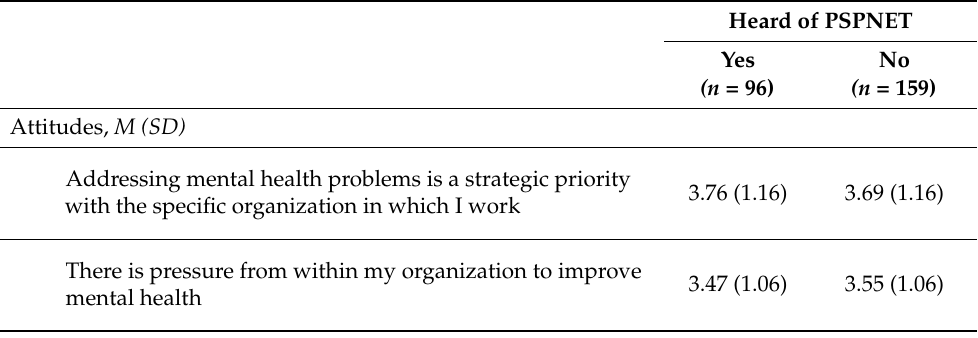
Table 5. Leaders’ perceptions of need for mental health services and support of ICBT